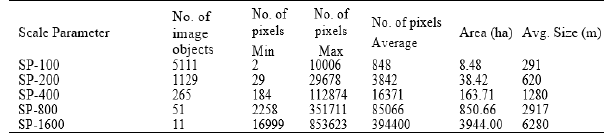
Table 1. Detailed statistics of the image objects for each scale parameter (Column 6: The average area of the image objects in hectare, Column 7: The average size of image objects for corresponding SP)